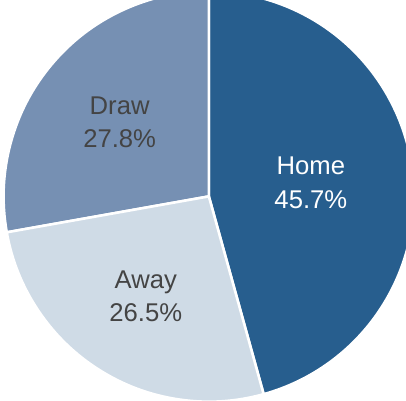
Figure 3. Full time results for the entire